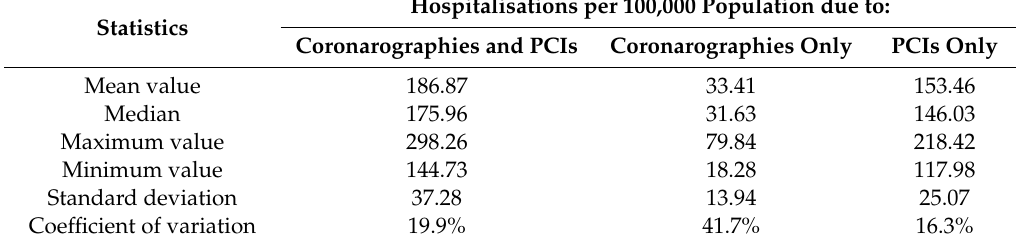
Table 3. Summary statistics of the invasive treatment of acute myocardial infarctions (AMI) in Poland